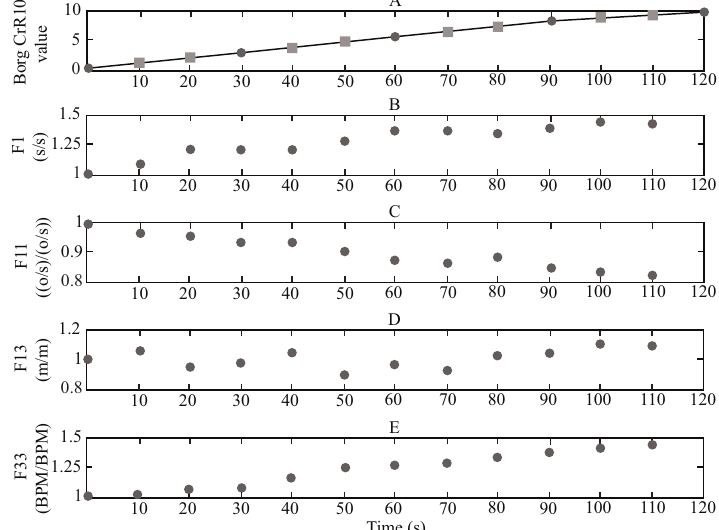
Figure 9. The behavior of the features normalized and fatigue level example, ( A ) Borg CR10 in- terpolated, ( B ) stand-to-stand time normalized, ( C ) Knee flexo-extension max velocity normalized, ( D ) Hip flexo-extension range normalized and ( E ) Heart rate